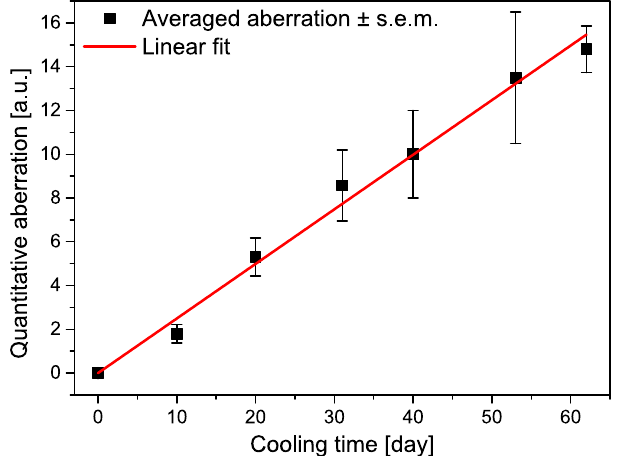
Figure 2. The averaged quantitative aberration of the ventral wing surfaces versus the cooling time of the pupae. For details of the conversion of pattern alteration into numerical values see the Supplementary Table 1. The red line is a linear fit to the numerically evaluated values of aberration (a = 0.24941 ± 0.00556,